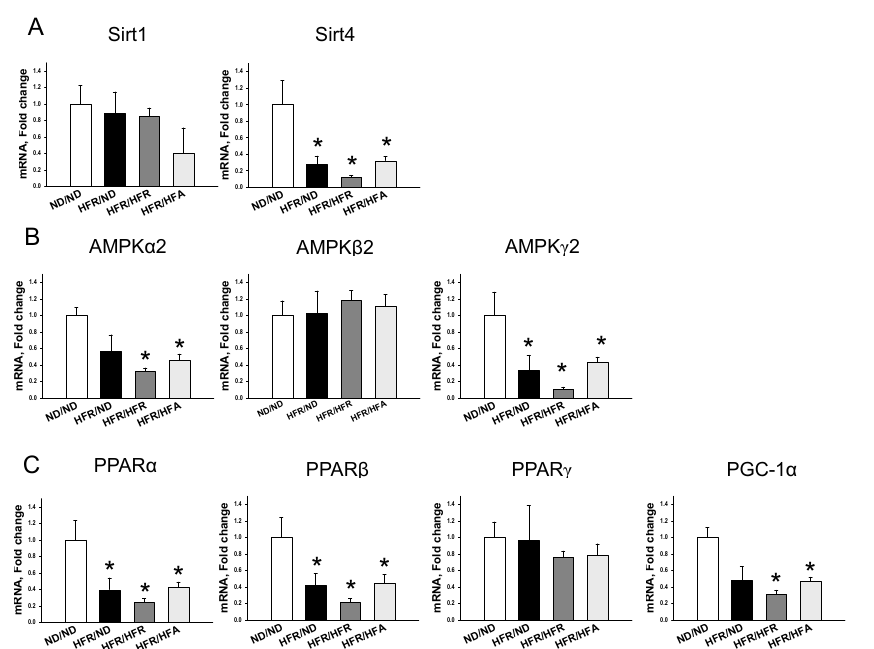
Figure 2. Effect of maternal and post-weaning high-fructose (HFR) and post-weaning high-fat (HFA) intake on mRNA expression of ( A ) silent information regulator transcript 1 (SIRT1) and 4 (SIRT4); ( B ) AMP-activated protein kinase (AMPK) α -, β -, and γ -subunits; and ( C ) peroxisome proliferator-activated receptor (PPAR) α -, β -, and γ -isoforms and PPAR γ coactivator-1 α (PGC-1 α ) in male offspring kidneys at 12 weeks of age. n = 8/group. * p < 0.05 vs. ND/ND.